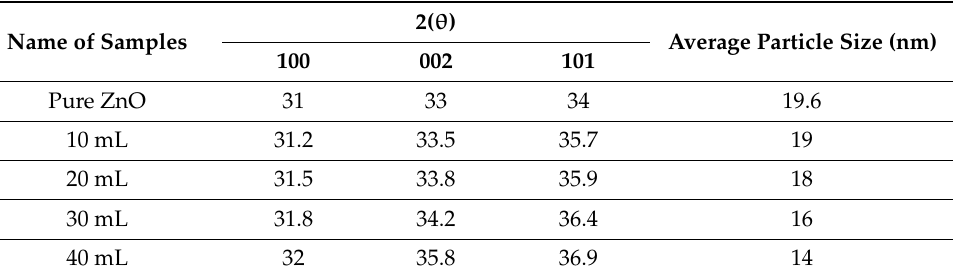
Figure 2. SEM images of ( a ) pure ZnO, ( b – e ) green synthesized ZnO samples treated with different amounts of leafy extract of S. oleracea (10 mL, 20 mL, 30 mL, and 40 mL), and ( f ) SEM image after reusability test.